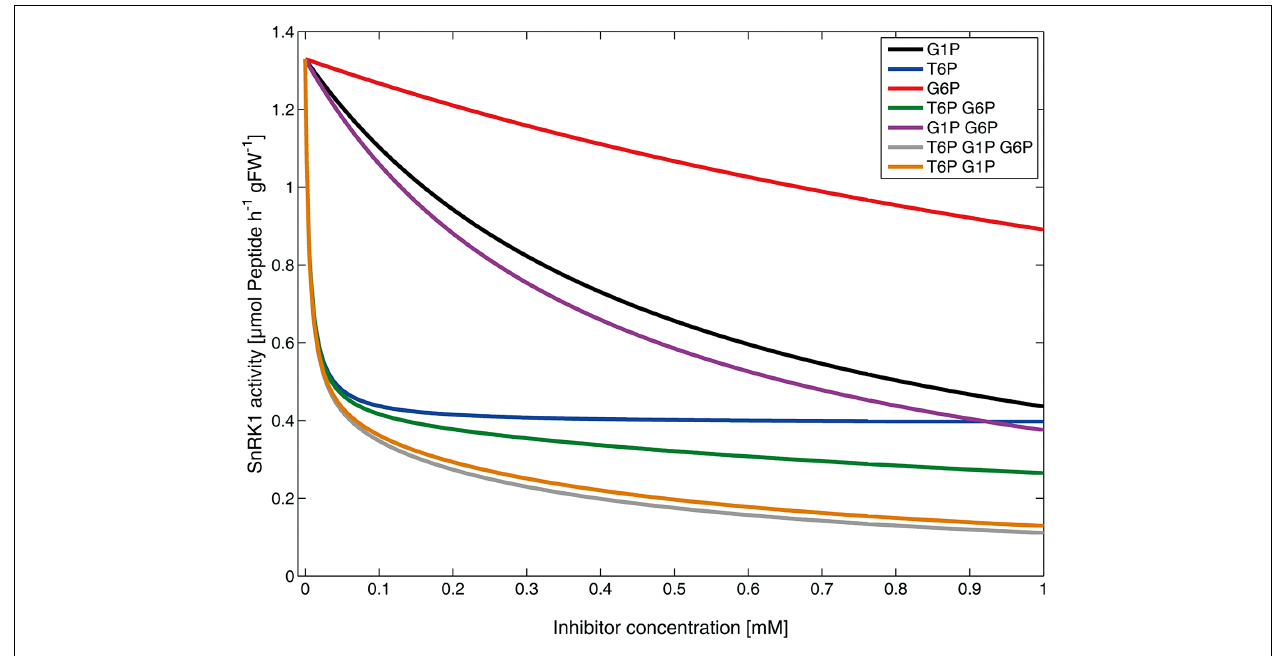
FIGURE 2 | Simulated kinetic effects of metabolic inhibitors on SnRK1 activity. Lines represent the rate of phosphorylation by SnRK1 ( v SnRK1 ), i.e., the solutions of equation (1), under various inhibitor concentrations and combinations.